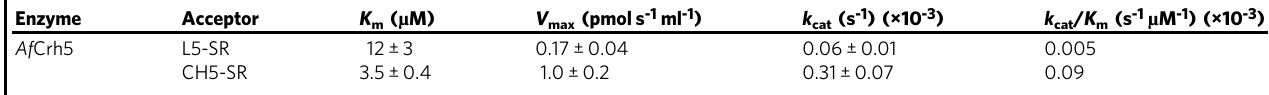
Table 1 Kinetic parameters of Af Crh5 with L5-SR and CH5-SR as the respective acceptors Enzyme Acceptor